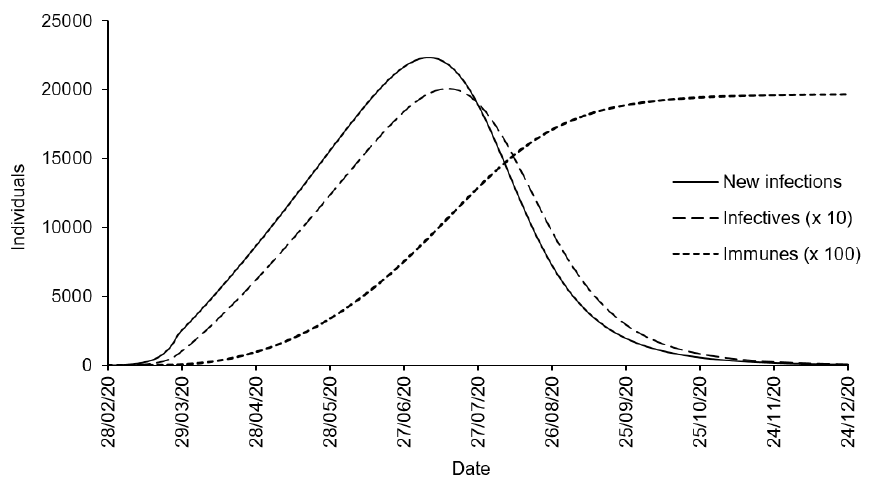
Figure 4. Estimates of the daily number of new infections, infectives and recovered individuals using the COVID-19 daily case reporting data from West Africa (28 February to 31 August 2020). The estimates are based on a SIQR model (see (16)–(19)) with rate parameters δ = 0.009 day − 1 (detection rate), γ = 1/11.9419 day − 1 (recovery rate for non detected), π = 1/61.4953 day − 1 (death rate for non detected), η = 35,615.35 individuals/day (recruitment rate) and µ = 2.1745 × 10 − 5 day − 1 (natural mortality rate).